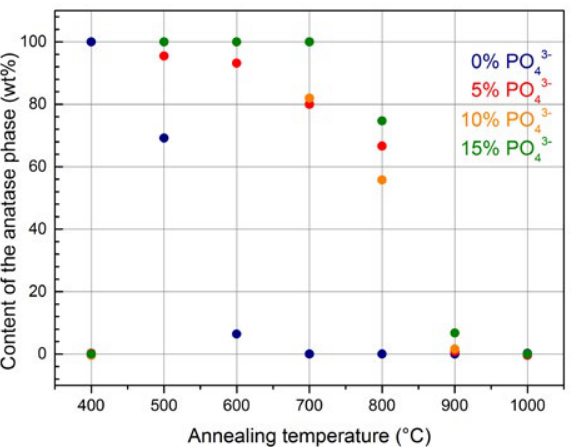
Figure 4. Content of anatase phase depending on the dopant ratio at different annealing temperatures in the powders.